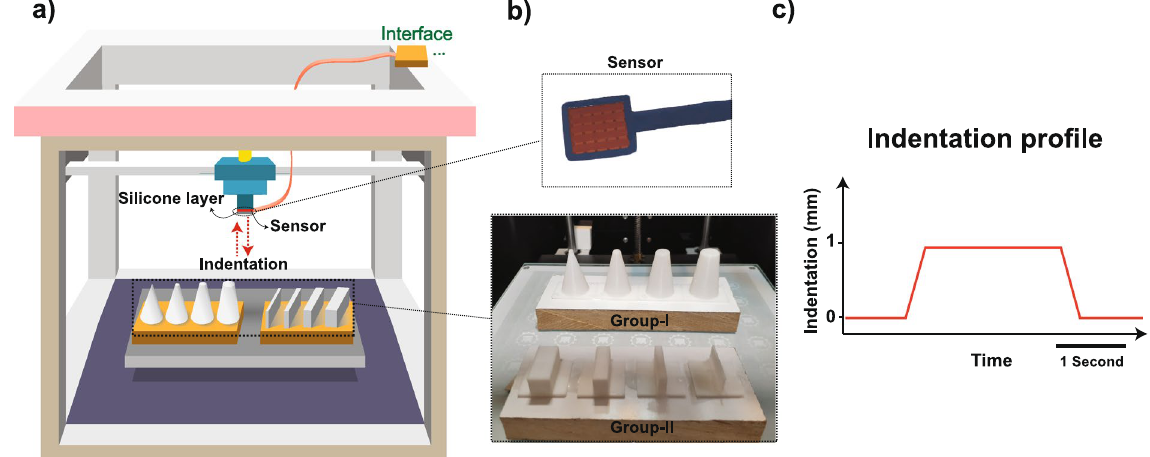
Figure 2. Illustration of the experimental setup which includes a robotic system with three-degree of freedom, tactile sensor, and 3D-printed objects. ( a ) The custom-built robot is equipped with a 5 × 5 tactile sensor. Red dash lines illustrate the touch protocol, where the sensor touches different objects. ( b ) Tactile sensor and 3D-printed objects. ( c ) Trapezoidal indentation profile. The hold phase of indentation lasts two seconds. Each object is touched by the tactile sensor 10 times and spike responses of the bio-inspired afferents/nociceptors are collected for further